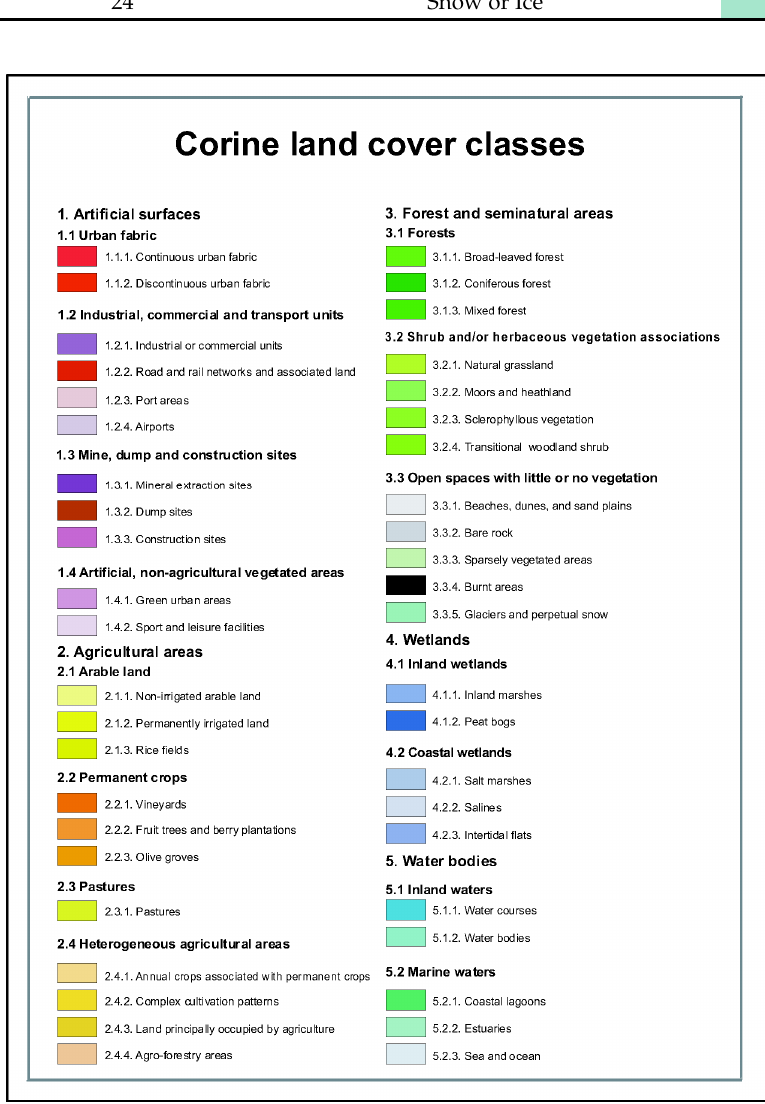
Figure A2. Classifications of all 44 Corine Land Cover classes with three hierarchical levels.